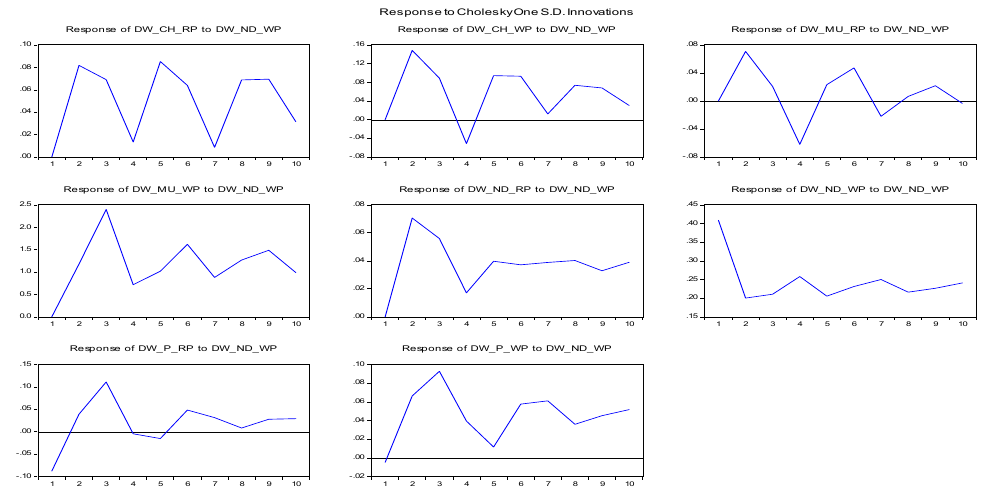
Figure 6. Impulse response of wheat market (Key market: New Delhi wholesale price) .